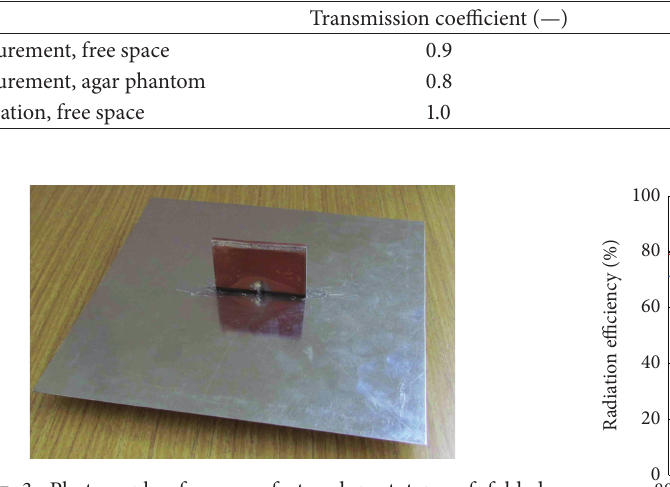
Figure 3: Photograph of a manufactured prototype of folded coupled patches RFID antenna in the monopole-type arrangement with the ground plane 130 × 130 mm 2 .